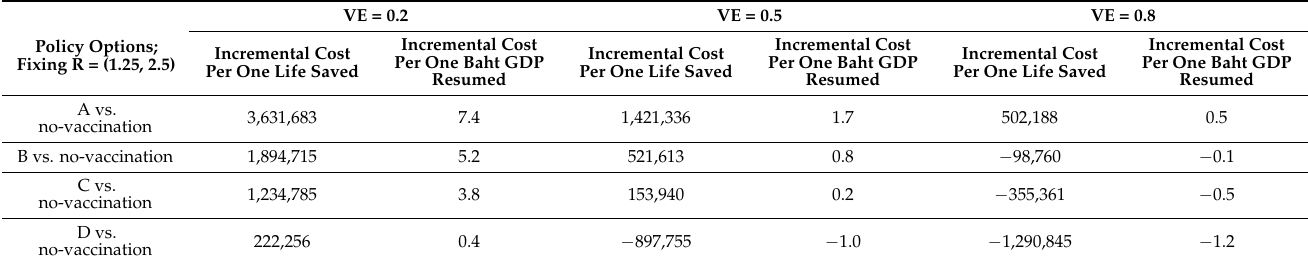
Table 8. Cost-effectiveness analysis by varying vaccine